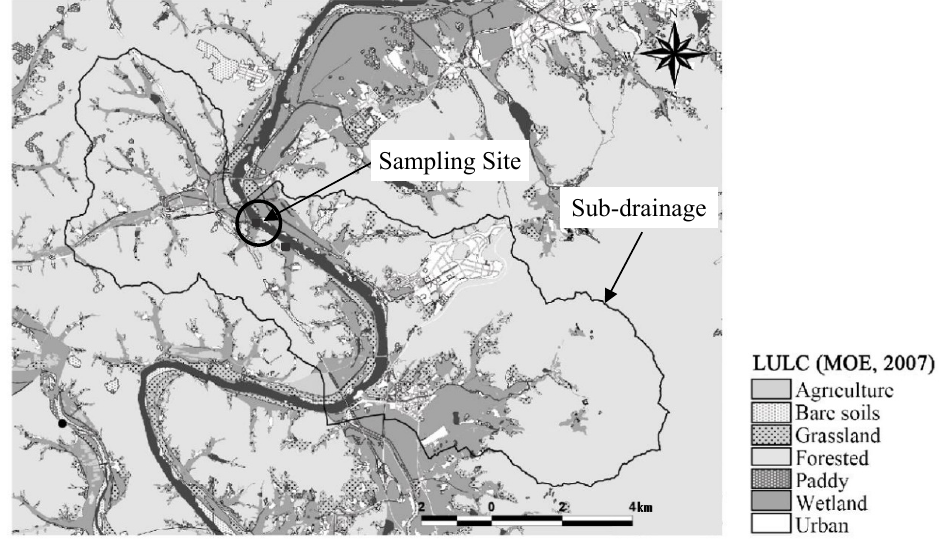
Figure 2. An example of a sub-drainage area used to measure the proportion of urban land use in an area adjacent to a monitoring site. Sub-drainage areas were delineated using a geographical information system (GIS) with a digital elevation map.